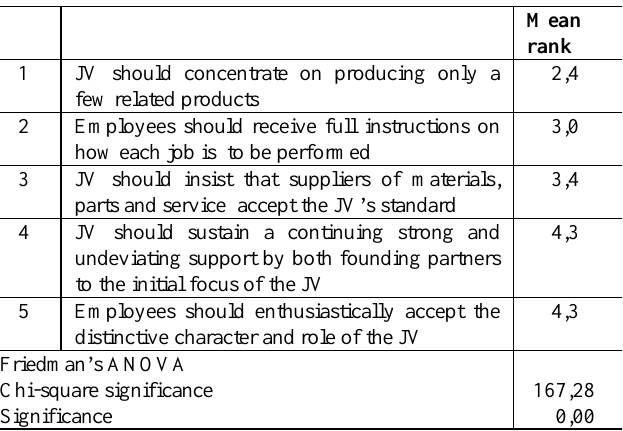
Table 3: Focused strategy for South African-US